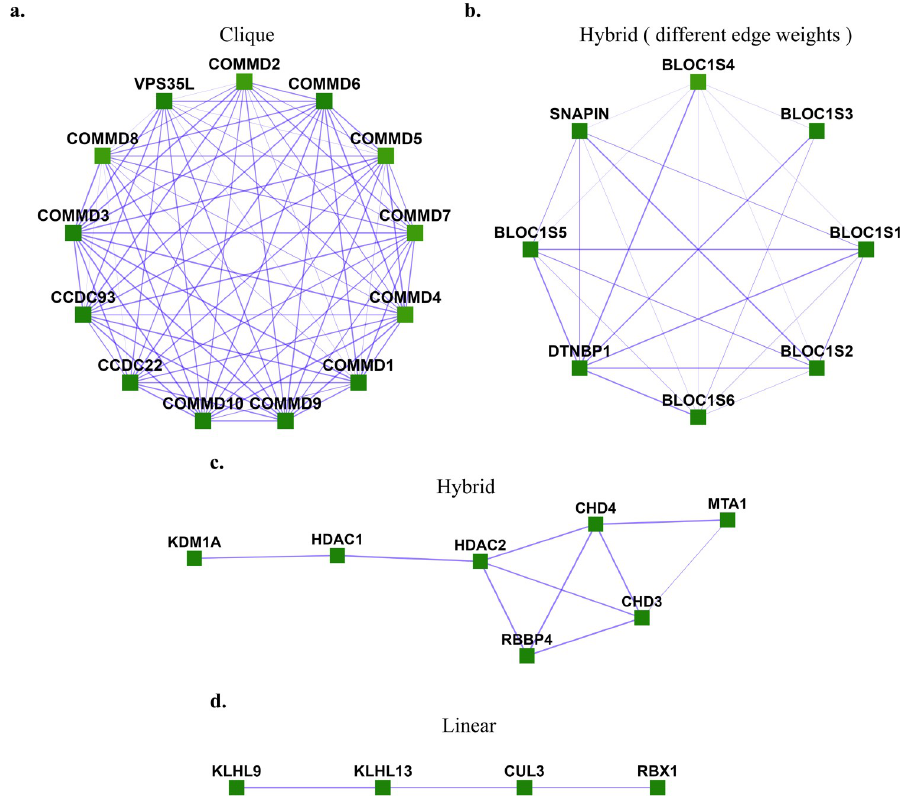
Fig 1. Different topologies are exhibited by human protein complexes. . a. Clique (Commander/CCC complex), b. Hybrid with different edge-weights (BLOC-1 (biogenesis of lysosome-related organelles complex 1)), c . Hybrid (NRD complex (Nucleosome remodeling and deacetylation complex), d. Linear (Ubiquitin E3 ligase (CUL3, KLHL9, KLHL13, RBX1)). These are experimentally characterized complexes from CORUM [3] with protein interaction evidence obtained from hu.MAP